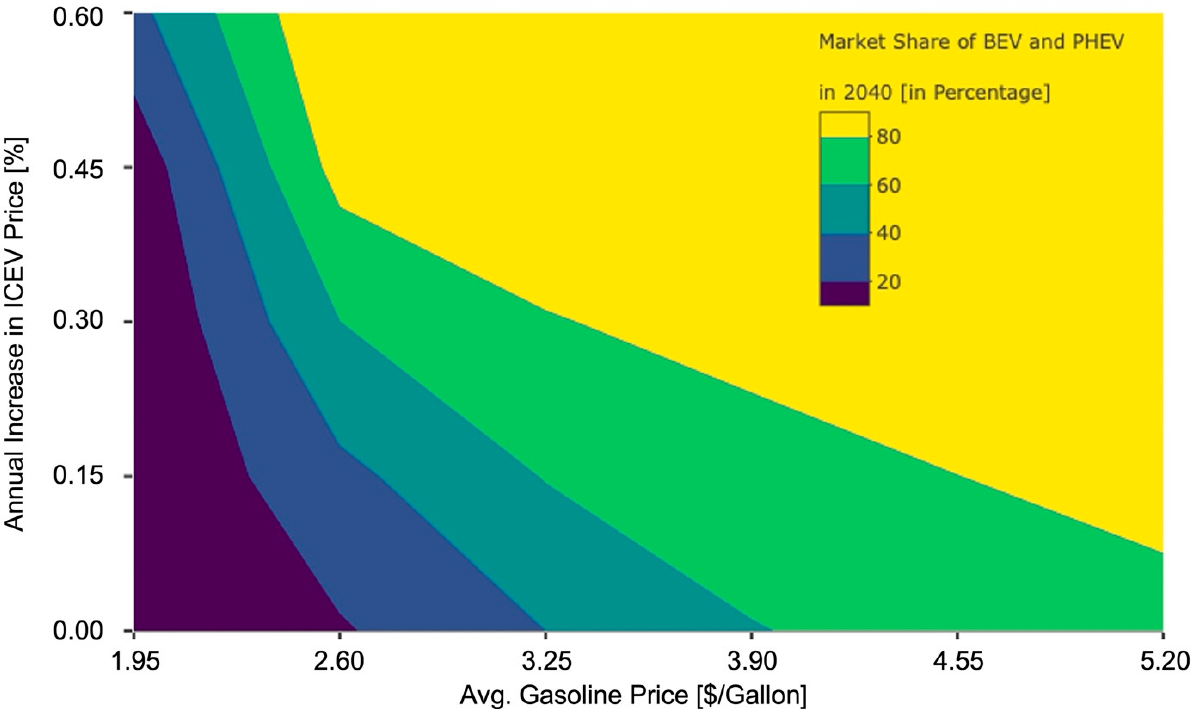
Figure 6. Market share of BEVs and PHEVs in 2040 for High Non-Battery Cost Model with variable gasoline price and the annual increase in conventional vehicle price (ICEV Cost Premium). At lower gasoline prices and without ICEV Cost Premium, BEVs and PHEVs remain more expensive than conventional vehicles. Expensive gasoline and/or ICEV cost increases will lead to a significant market share for BEVs and PHEVs in 2040 (1 USD/gallon ≈ 0.25 EUR/L).